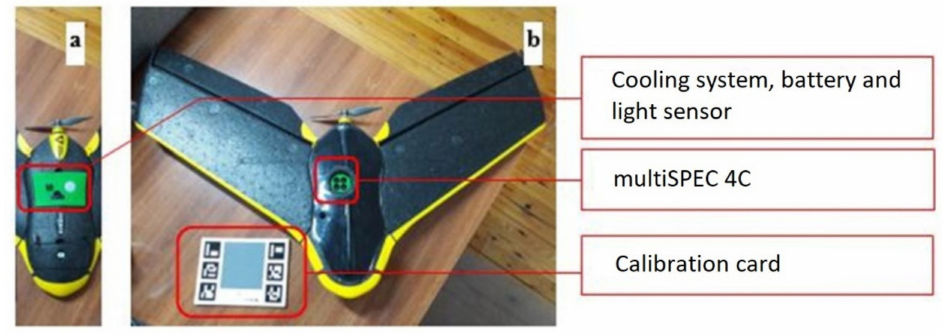
Figure 3. Top ( a ) and bottom ( b ) of eBee with details of components.